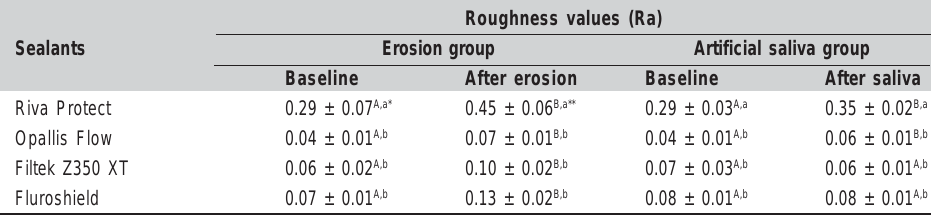
Table 2 - Surface roughness (Ra) of the sealant materials after erosive challenge and immersion in artificial saliva (control). Values are expressed as means ± standard deviations (µm).